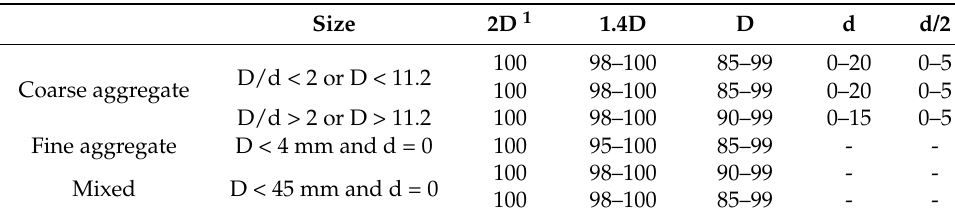
Table 1. Particle size distribution requirements for concrete manufacturing.